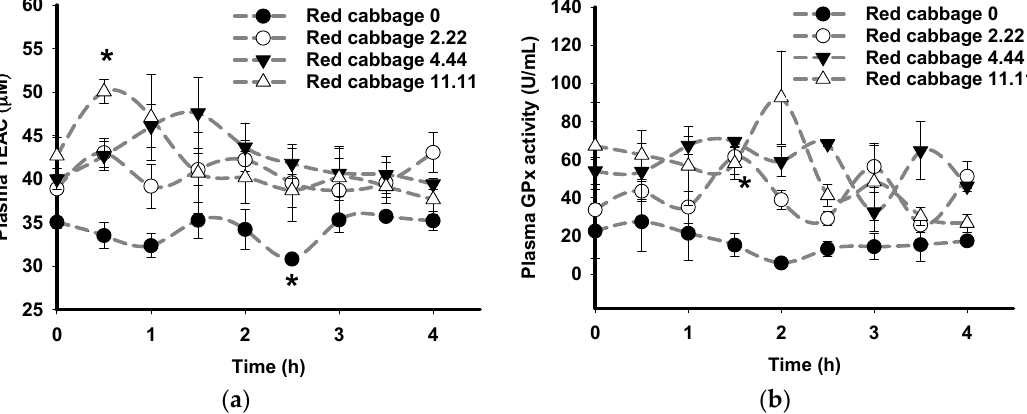
Figure 2. Effects of oral consumption of red cabbage extract on the plasma antioxidant status of pigs. Pigs consumed red cabbage extract at four doses in mg gallic acid equivalent/kg body weight: 0 (black circle), 2.22 (white circle), 4.44 (black triangle), and 11.11 (white triangle). Plasma antioxidant status was measured as: ( a ) plasma Trolox equivalent antioxidant capacity (TEAC); and ( b ) plasma glutathione peroxidase (GPx) activiy. Data points labelled “*” are significantly different from baseline at time 0 ( p ≤ 0.05, Tukey’s test). Results represent the mean and error bars represent standard error of the mean ( N = 3).